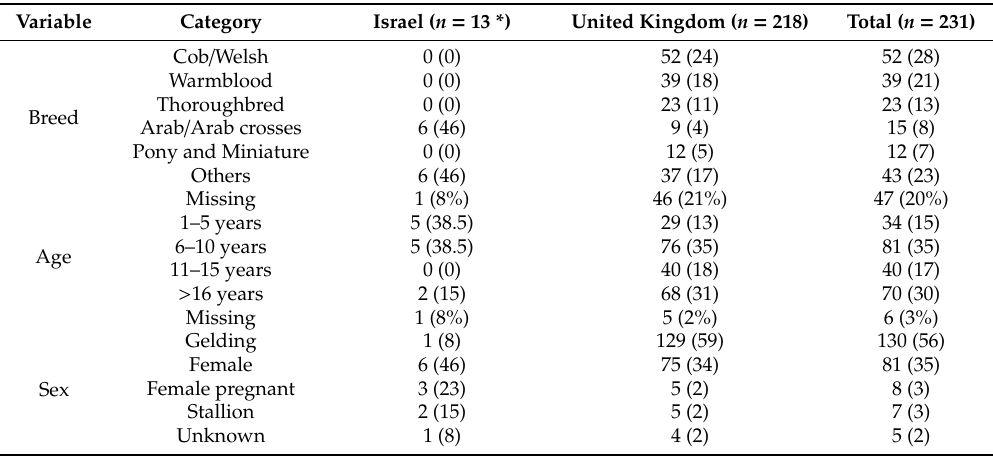
Table 3. Characteristics of horses presented with colic that were included in the study ( n = 231) assessing colic pain severity by location (Number